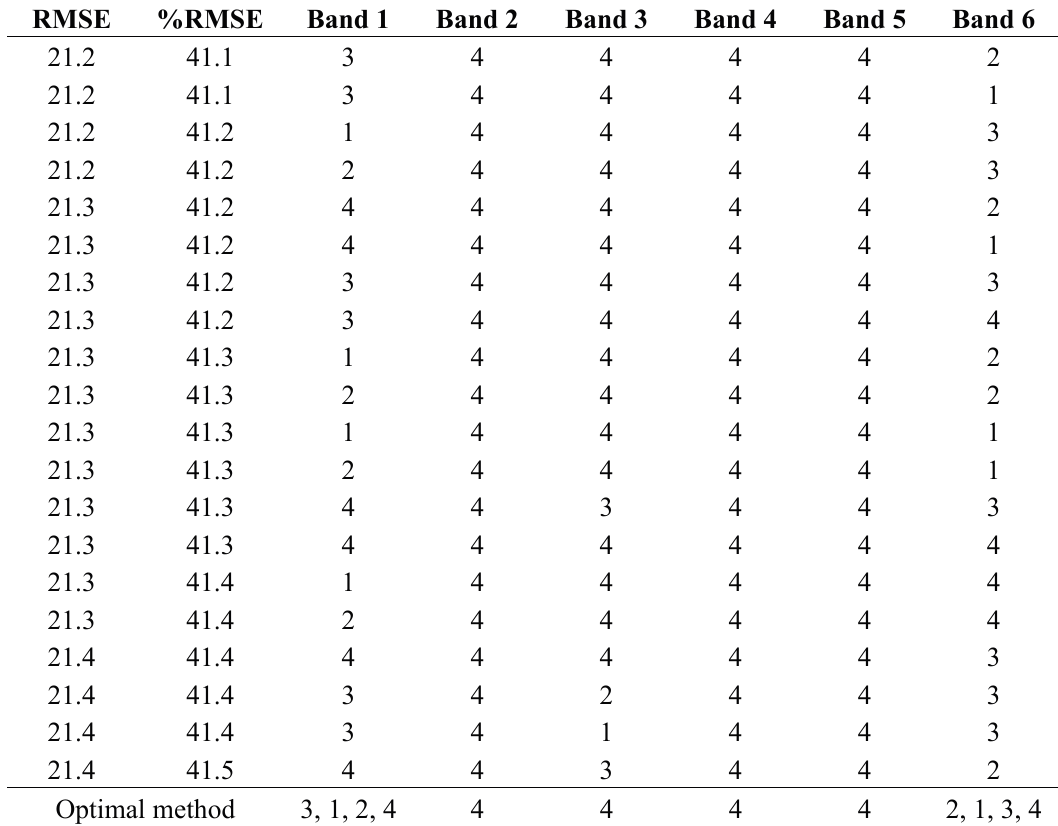
Table 7. Accuracy assessment results for 8th August 2010 Landsat ETM+ by four atmospheric cases: RMSE (unit: tonC/ha) and %RMSE (unit: %); for band area: four atmospheric correction options, TOA, DOS, FLAASH and 6S are named 1, 2, 3 and 4,